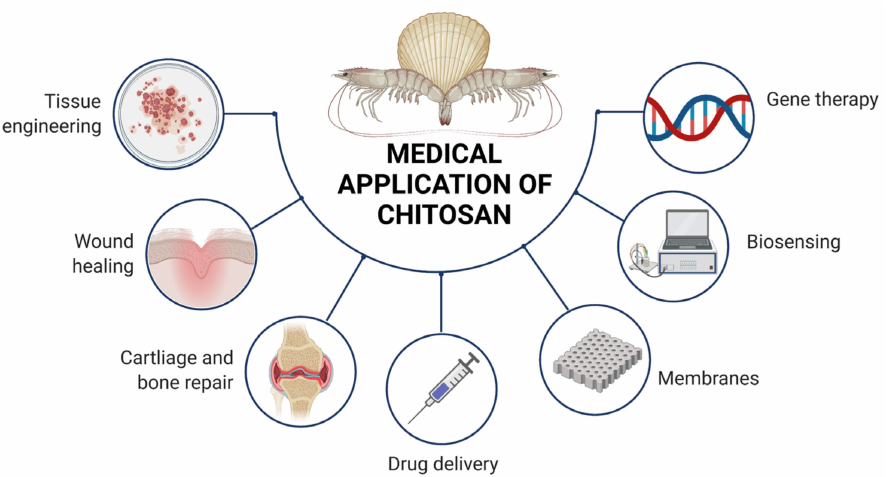
Figure 6. Medical application of chitosan based on the literature [74–101]. Figure 6 was created with BioRender.com. (accessed on 17 December 2021.).